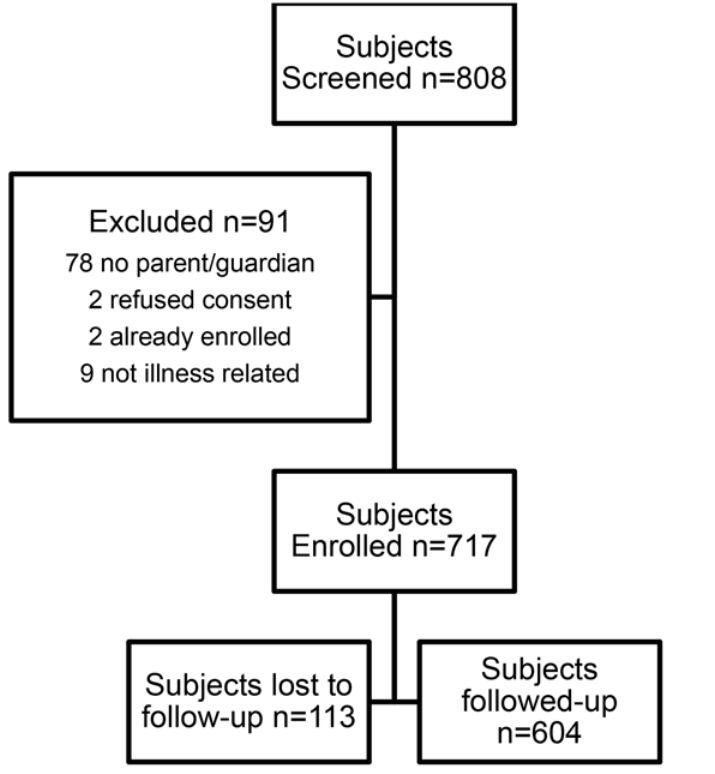
Fig 1. Consort Diagram of study